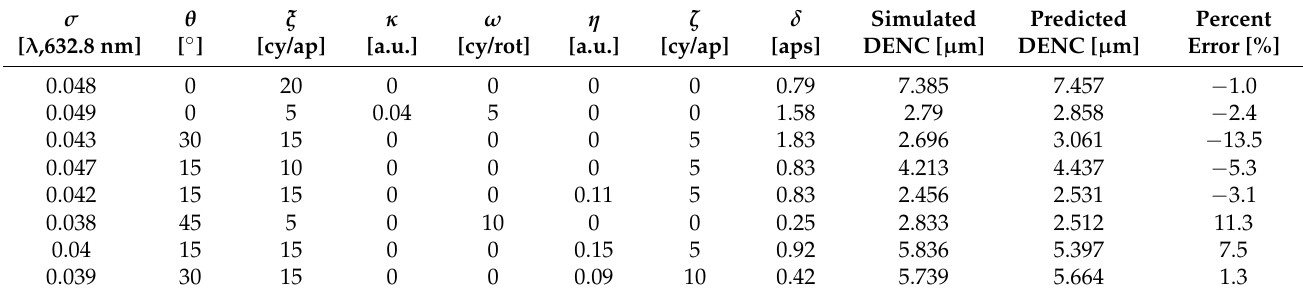
Table 11. Diffraction Encircled Energy (DENC) Characteristic Fit Error, Random Sub-Selection of Inputs.